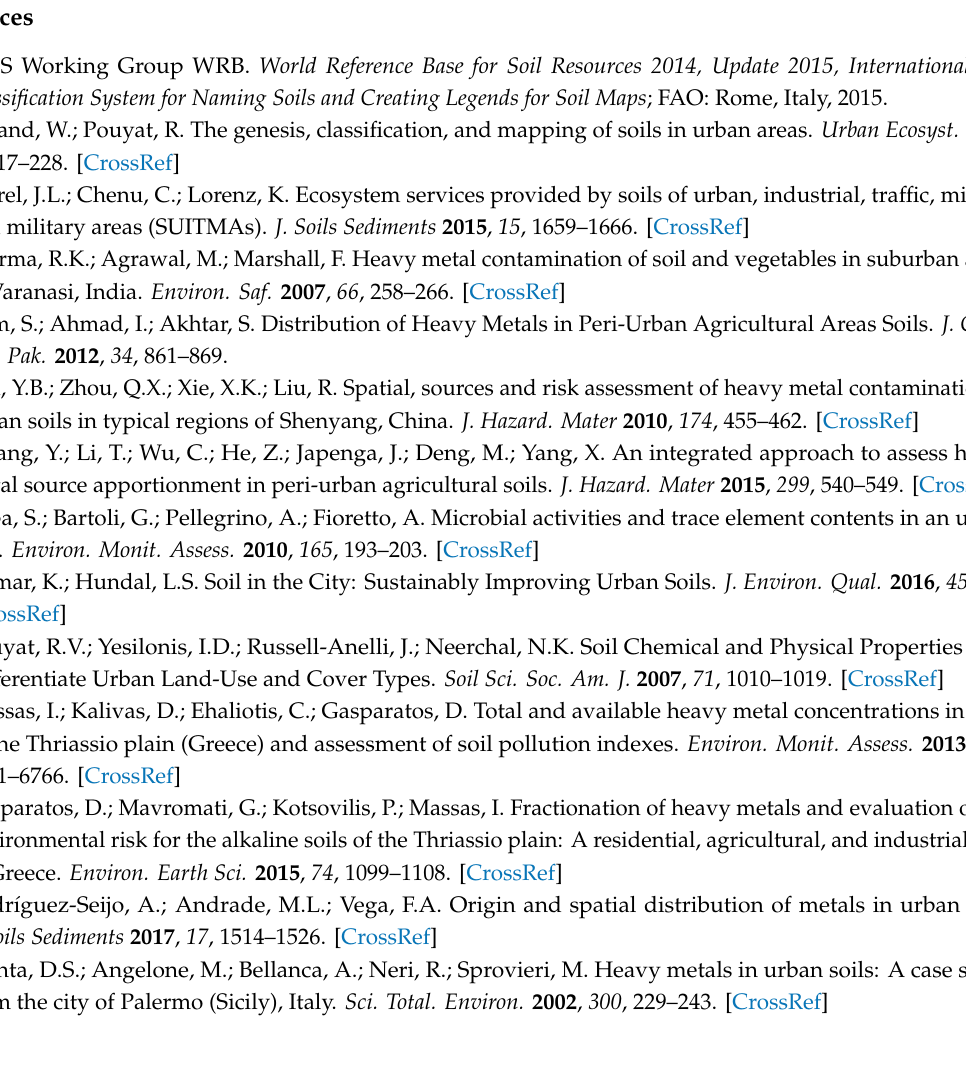
Table S1: Concentrations of potentially toxic elements in urban soils of Havana. Raw